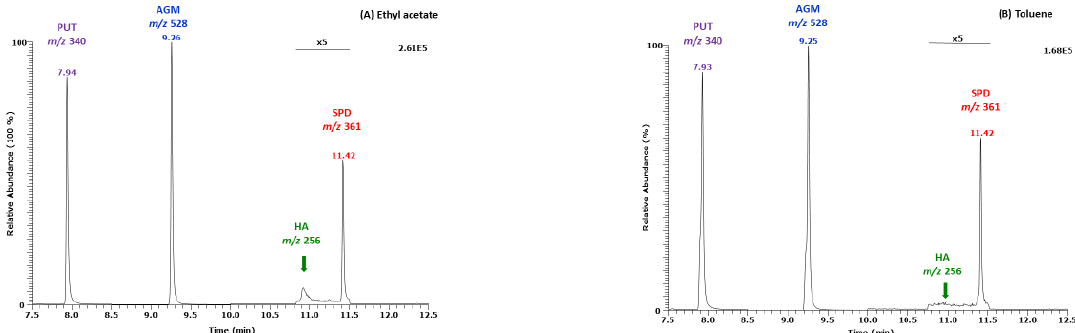
amine amount (x), and signal-to-noise ( S/N ) values. Table 1 also reports the peak area ratio (PAR) of the PFP derivatives of 13 C 0 -SPD-(PFP) 3 and 13 C 4 -SPD-(PFP) 3 . The detailed results of this experiment for PUT, AGM, and SPD are presented in the Supplementary Material (Table S1) to this work.